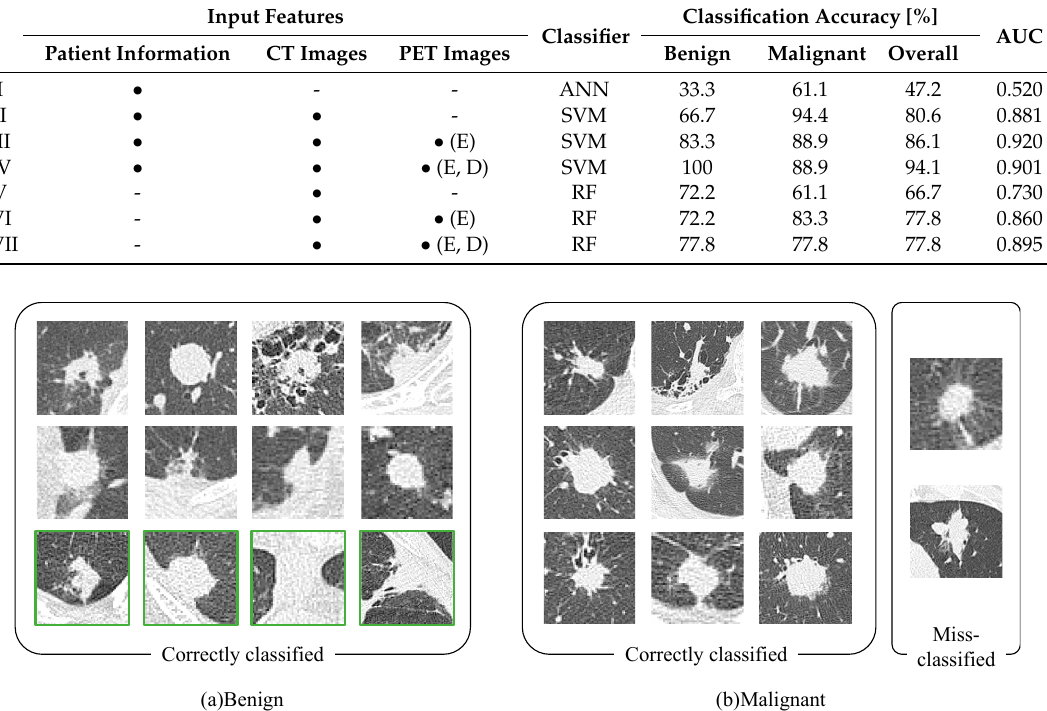
Table 4. Classification results for different input features. The results of I–IV were obtained using the proposed method. The results of V–VII were obtained using the previous method [18].